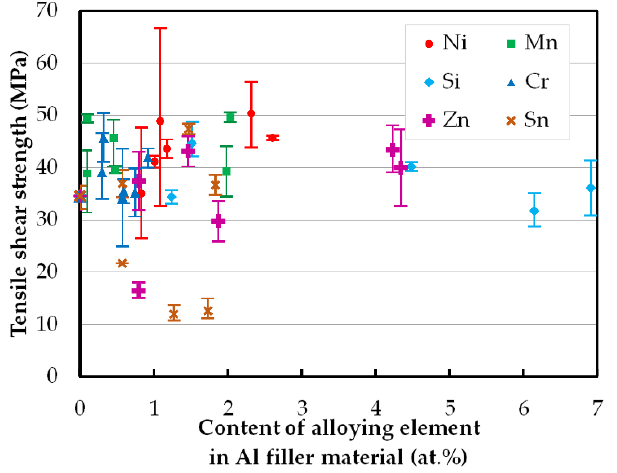
Figure 3. Effect of alloying elements in the Al filler material on the strength of the Al/Cu dissimilar joints.